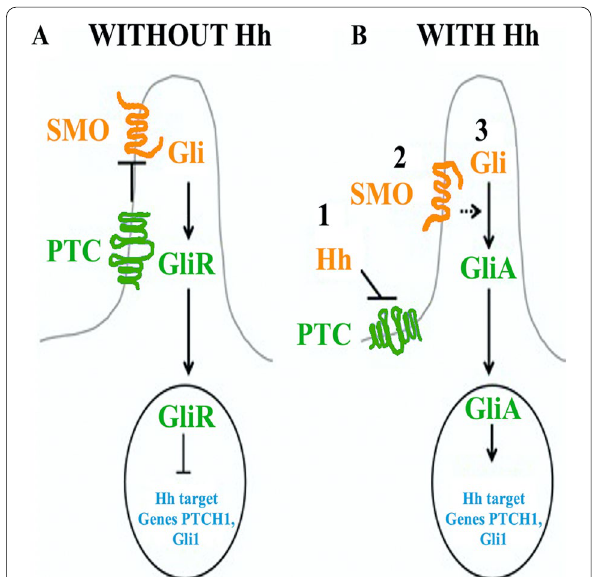
Fig. 1 SHH signaling pathway. Hh receptor PTC inhibits SMO signaling via an unknown mechanism, in the absence of the Hh ligands, and Gli molecules, processed into repressor forms, turn off the Hh-signaling pathway ( a ). PTC is unable to inhibit SMO in the presence of Hh. Gli molecules, processed to active forms (GliA), activate Hh target genes ( b ). Abbreviations: Gli glioma-associated oncogene, Gli1 glioma-associated oncogene 1, GliA glioma-associated oncogene activator, GliR glioma-associated oncogene repressor, Hh hedgehog, SMO smoothened, PTC patched, PTCH1 protein patched homolog